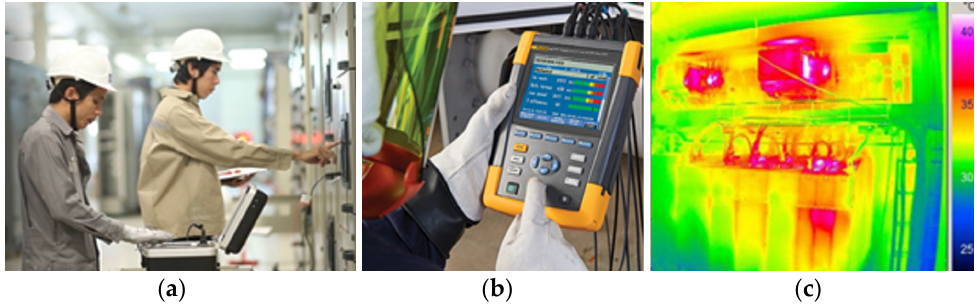
Figure 1. A display of status checks on electrical system: ( a ) heat checked by inspectors; ( b ) thermal- imaging sensor technology temperature check; ( c ) display of the thermal temperature results, with green areas indicating low-temperature area and red areas indicating high temperature.